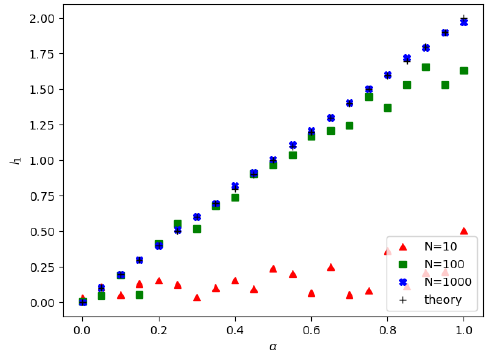
Figure 13. Comparison of coherence: σ = 1.